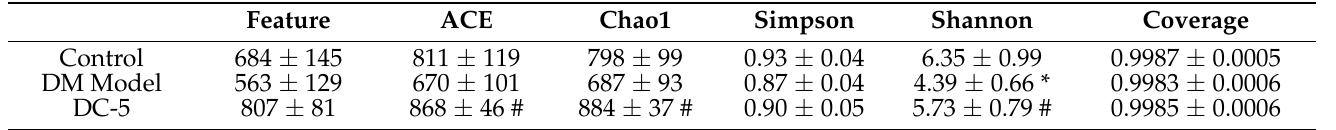
Table 3. Comparison table of Alpha diversity indexes between normal rats, diabetic rats and DC-5 treated diabetic